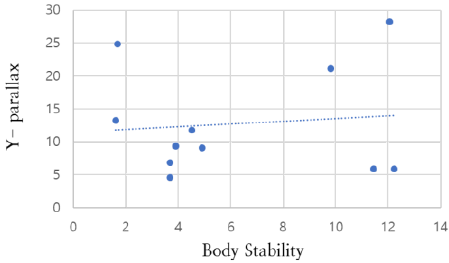
Figure 9. Relationship between body stability and accuracy of epipolar